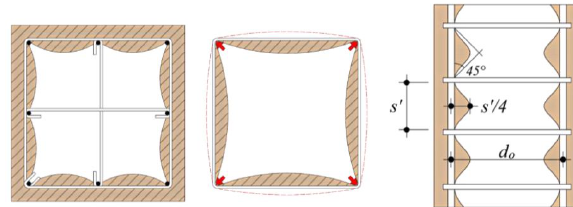
Figure 1: Sketches of the “effectively confined core” concept on square concrete column elements